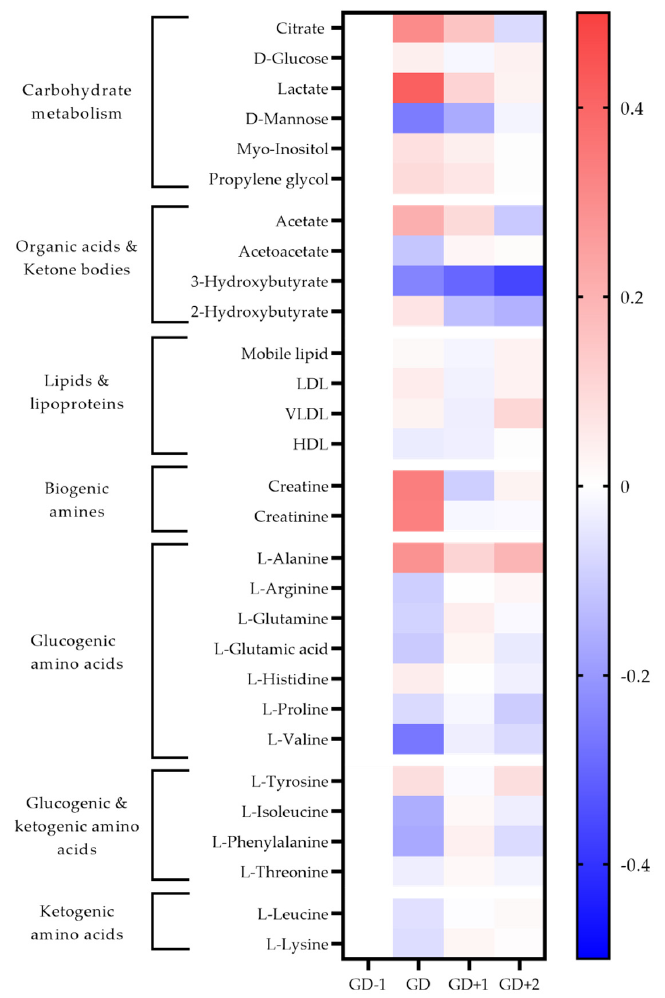
Figure 2. Heatmap of metabolites identified as significant via univariate analysis and as key discriminators between timepoints via PLSDA modelling in blood serum samples. The fold change calculated from the GD − 1 sample is displayed as the natural logarithm to indicate an increase (greater than 0, red) or decreased (less than 0, blue).